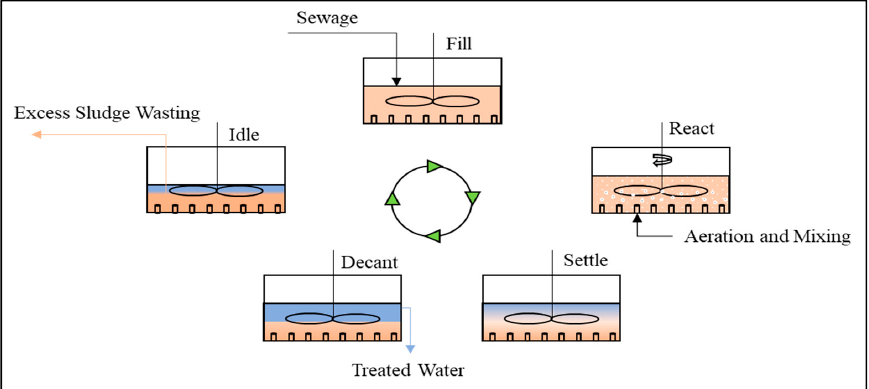
Figure 7. Process steps of SBR in one basin. Adapted with permission from ref. [53]. Copyright 2010 Elsevier.